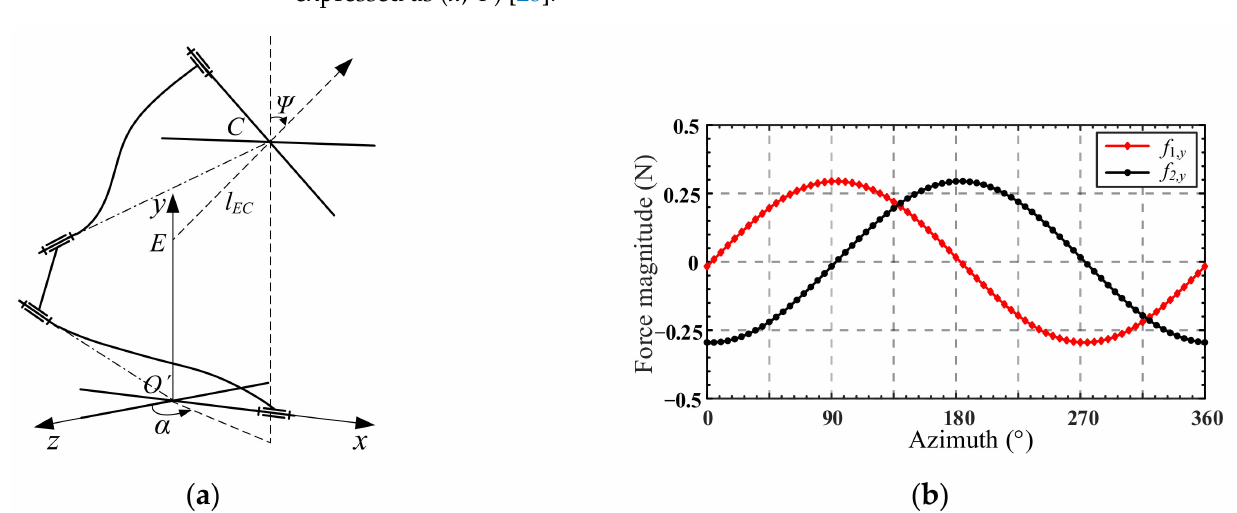
Figure 14. ( a ) Spatial pointing of mechanism; ( b ) curves of input